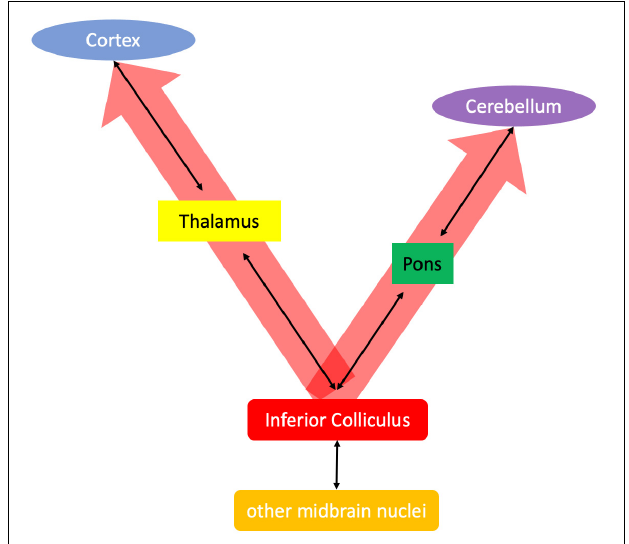
FIGURE 3 | Proposed alerting function of the inferior colliculus accomplished by synchronizing thalamocortical and pontocerebellar